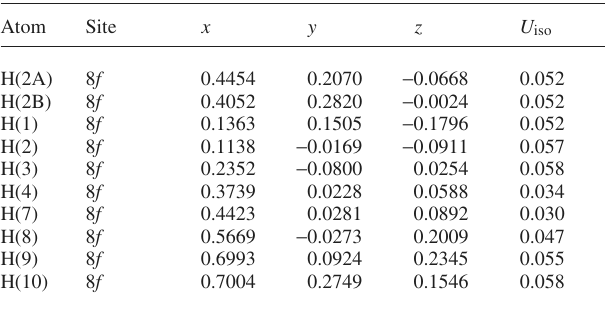
Table 2. Atomic coordinates and displacement parameters (in Å 2 )